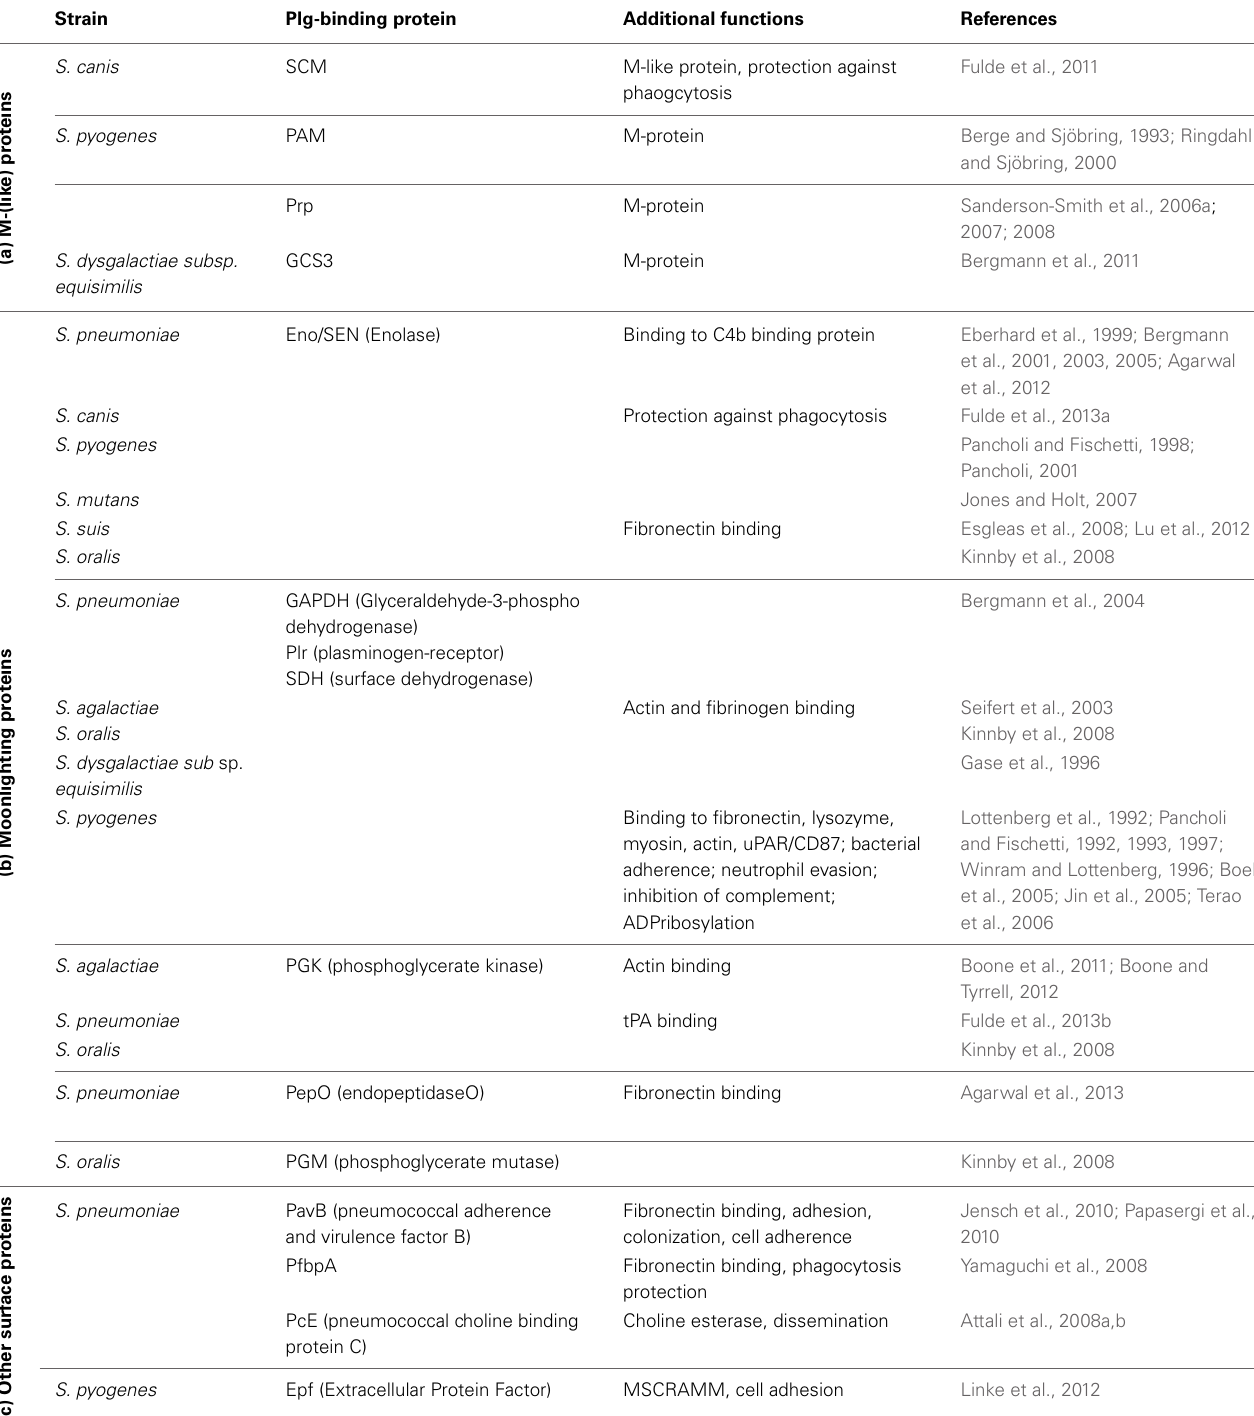
Table 1 | Plasminogen-binding proteins of different streptococci and additional functions.